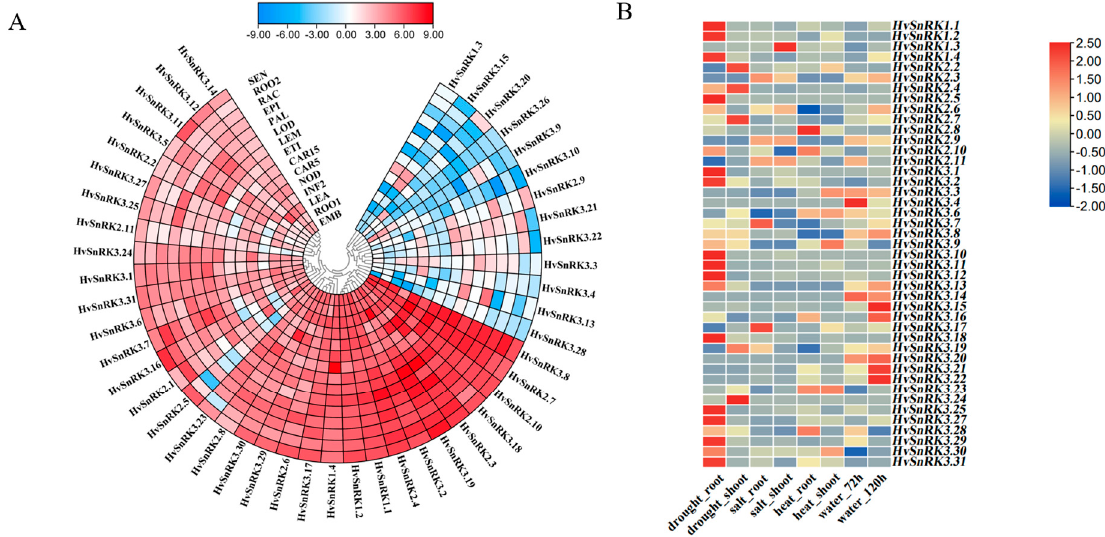
Figure 7. Expression profiles of HvSnRK genes. ( A ) Transcriptional profiles of the HvSnRK genes in barley different tissues. ( B ) Transcriptional profiles of the HvSnRK genes under abiotic stresses. The color scale represents expression data with row scale. Blue: Low expression; Red: High expression.